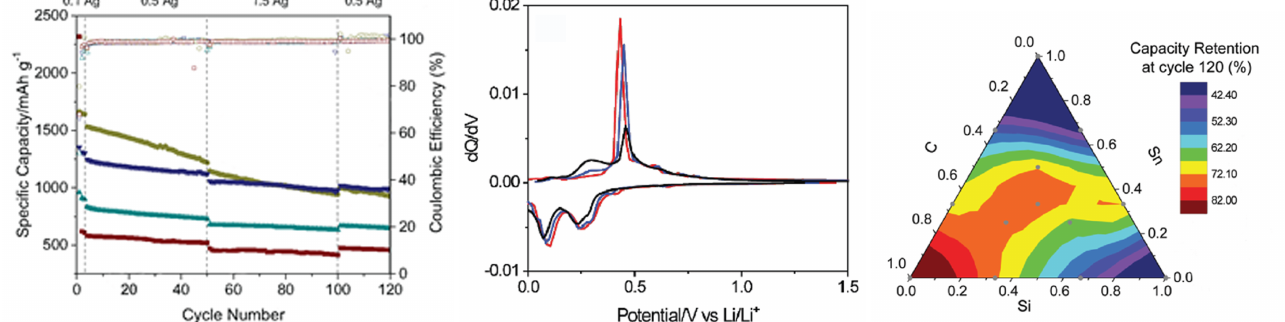
Figure 24. Specific capacity, cyclic voltammetry, and capacity retention for Si/C/Sn composite anode [116]. Copyright Wiley-VCH GmbH. Reproduced with